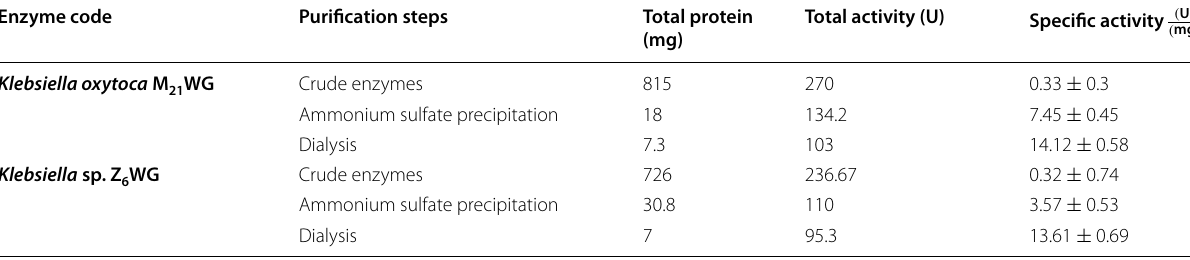
WG) and Klebsiella sp. (Z 21